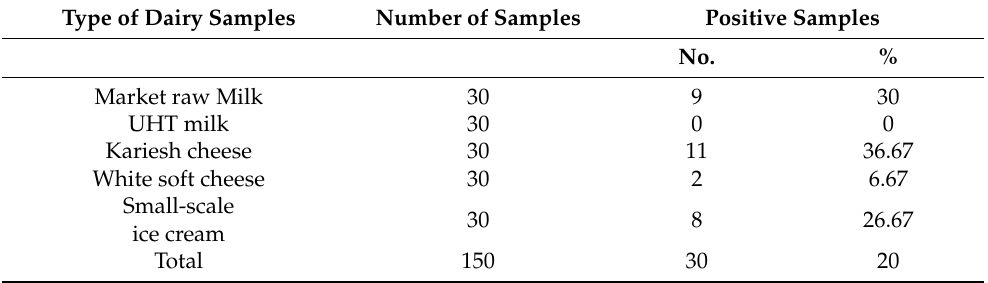
Table 2. Prevalence of E. coli in milk and dairy products. Type of Dairy Samples